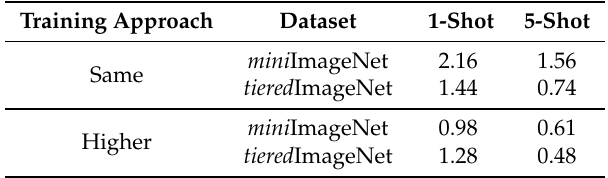
Table 4. Performance gain (in % points) of Looking-Back vs transductive propagation network (TPN) on the test sets when using lower-level information in same-shot (Same) and higher-shot (Higher)